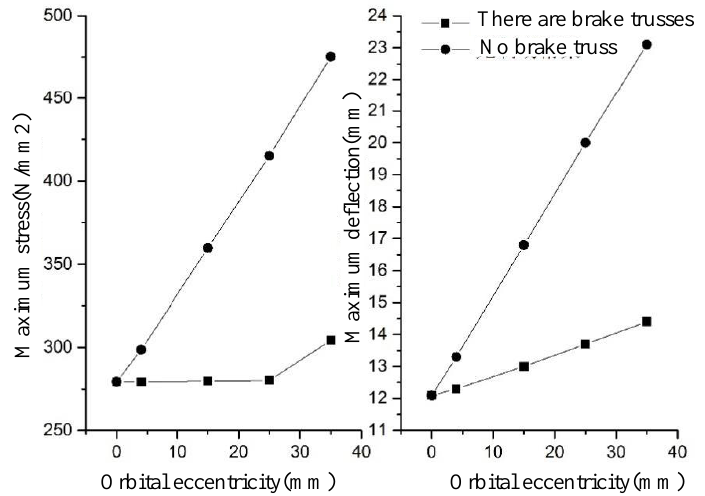
Figure 6. Stress and deflection of 2 m crane beam under eccentric track loading.